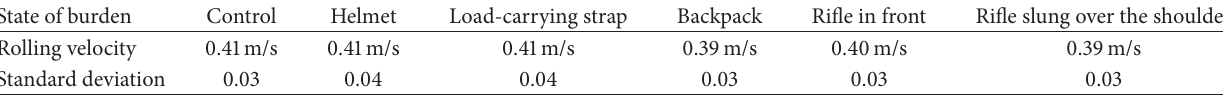
Table 2: Rolling velocity during